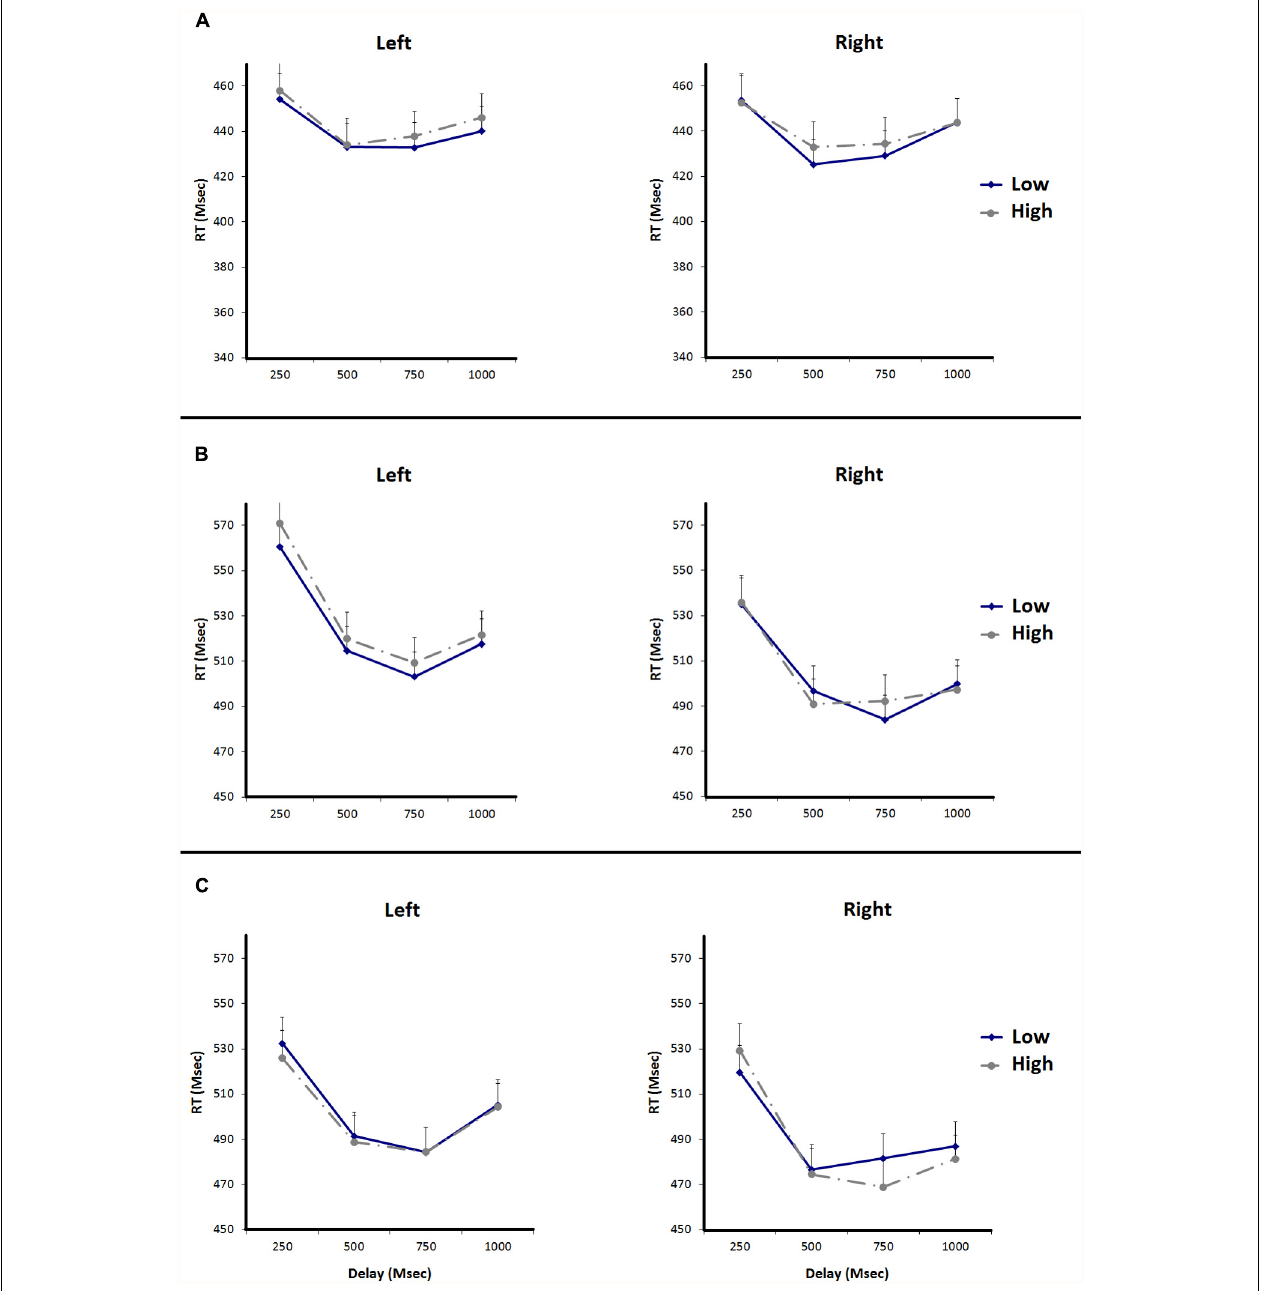
FIGURE 3 | Reaction times for the target detection task of replications experiments 1, 2, and 3. Error bars represent standard errors of the mean difference between adjacent data points. (A) Shows the RTs of Replication Experiment 1, (B) shows the RTs of Replication Experiment 2, and (C) shows the RTs of Replication Experiment